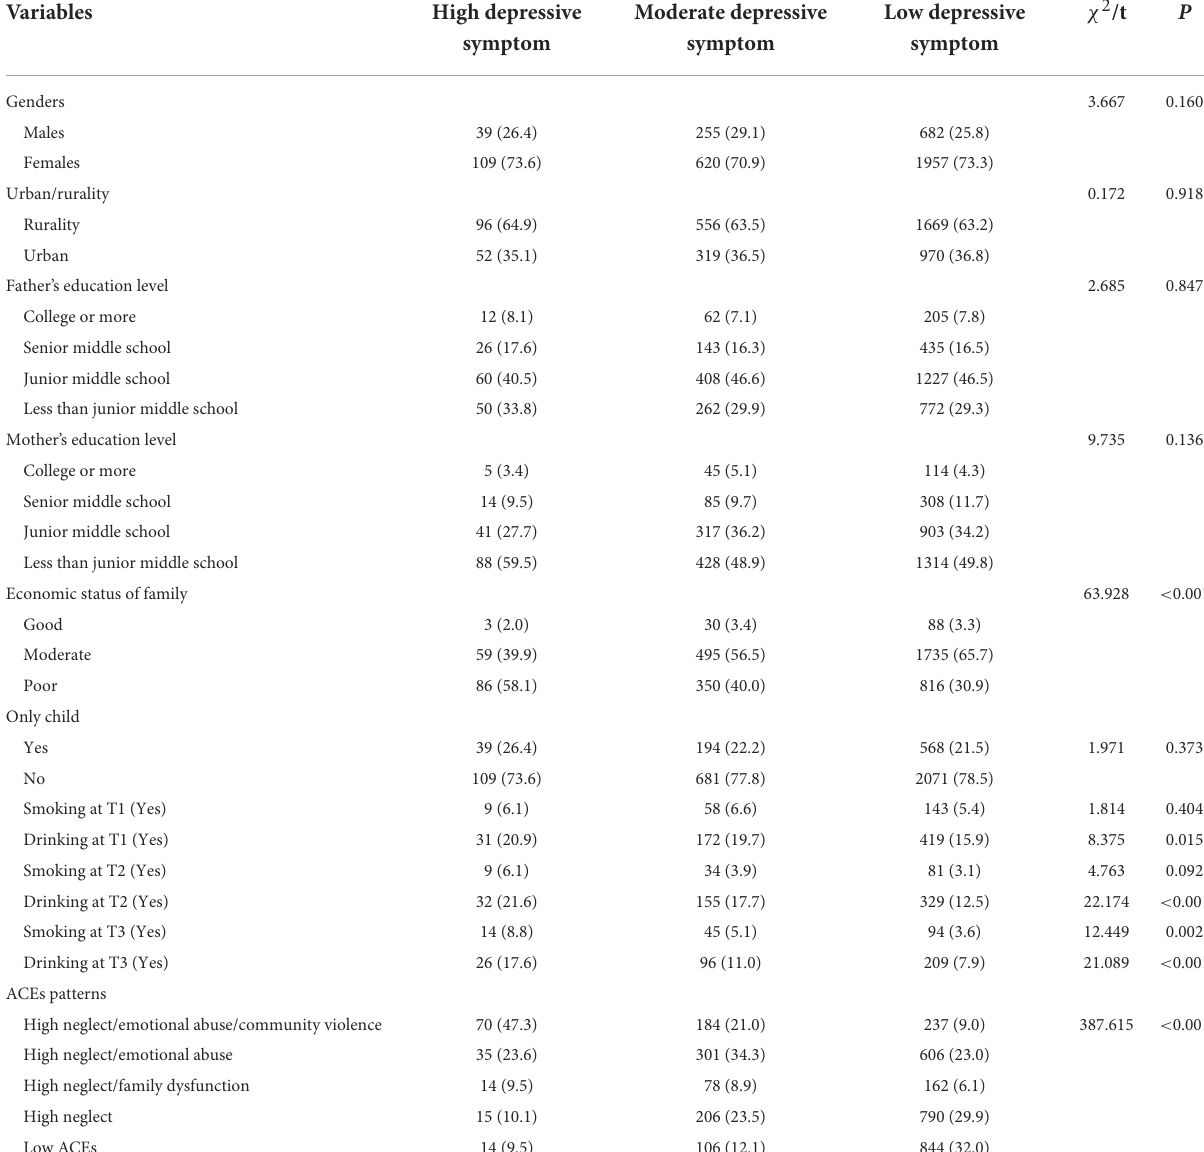
TABLE 1 Characteristics of participants by depressive symptom trajectories, data shown as n